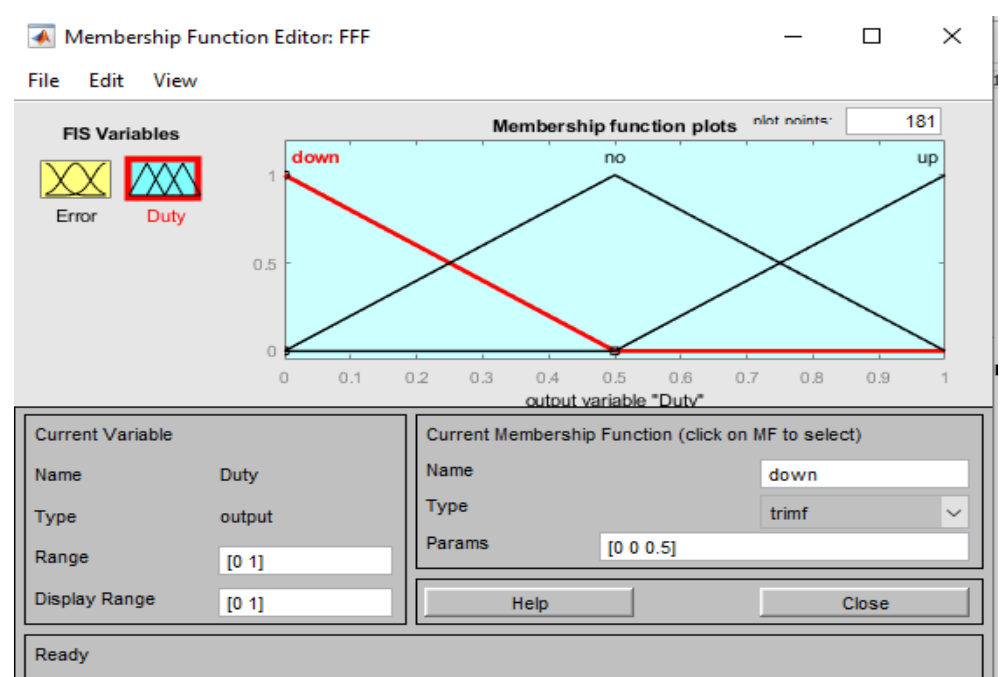
Figure 13. Membership function for output.